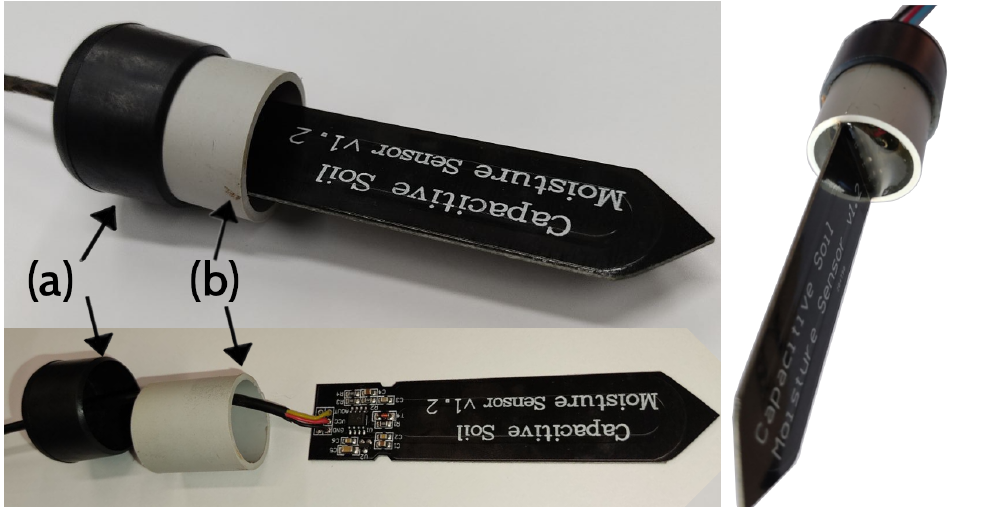
Figure A4. Exploded view of the housing components of the low-cost soil moisture sensor: ( a ) Plastic cape tube to contain the crystal epoxy resin during the filling process. ( b ) Section of a plastic tube to avoid movement of the sensor during the filling process. On the right-hand side, soil moisture sensor